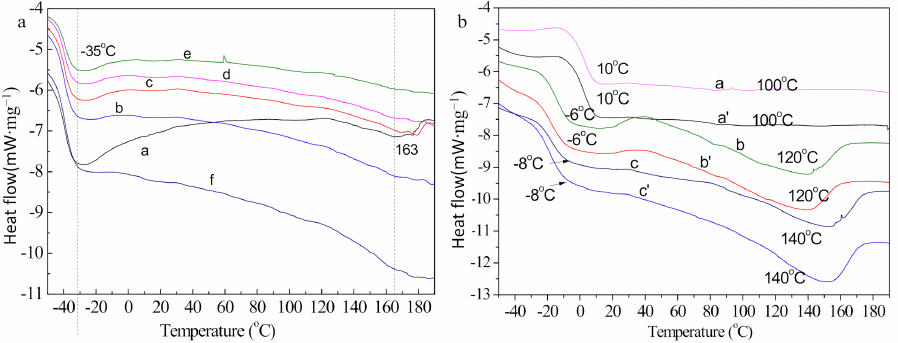
Figure 6. DSC measurements of G-TPU composite films prepared from TPU with melting points of 163 ◦ C and the graphene with different mass contents (Figure 6a) and G-TPU composite films prepared from TPU with the melting point of 100 ◦ C (Figure 6b, curve a, a’), 120 ◦ C (Figure 6b, curve b, b’), 140 ◦ C (Figure 6b, curve c, c’), respectively, and the graphene mass content of 4 wt% (Figure